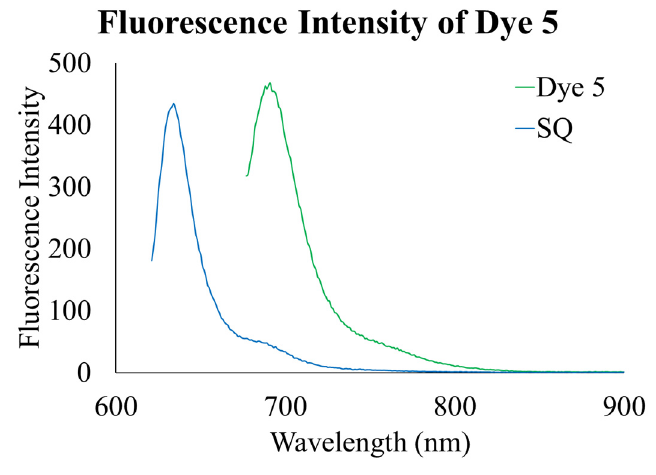
Figure 3. Fluorescence intensity of dye 5 (0.0125 µM) compared to SQ (0.0125 µM) in methanol.